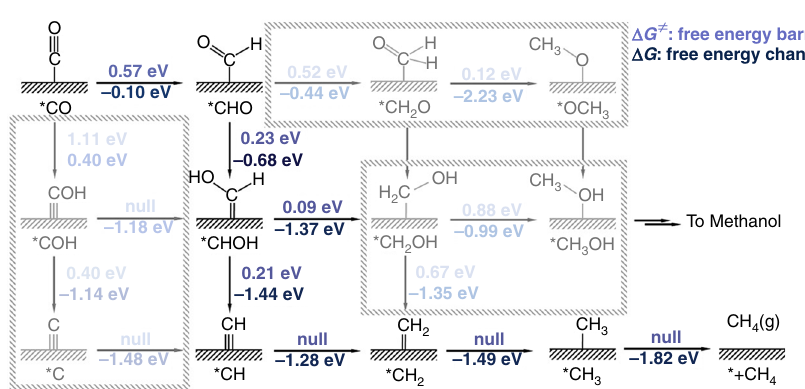
Fig. 2 Kinetics and free energy diagram for all possible pathways toward C 1 products. CO is reduced to C 1 products on the Ag-Cu surface. The values shown blue (upper) and dark blue (bottom) are the free energy barrier and free energy change at − 1.0 V SHE for all steps, respectively. Adsorbates with an asterisk correspond to species that are adsorbed on the surface. Null stands for no free energy barrier